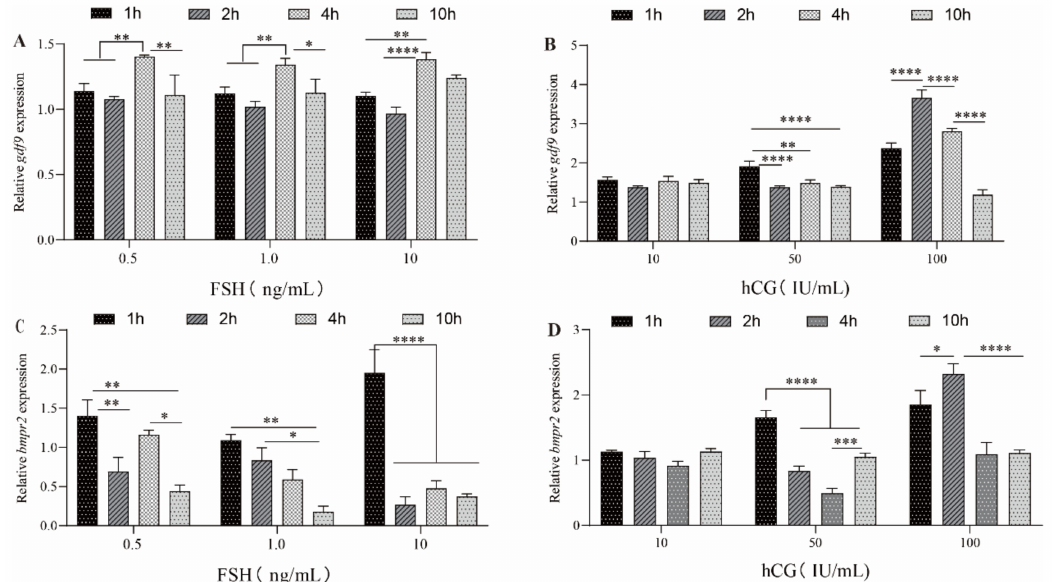
Figure 6. Expression of gdf9 and bmpr2 in ovarian tissue of ricefield eel after FSH and hCG incubation in vitro. Results are expressed as means ± SEM (error bars), which were compared with the control group. ( A , C ) The relative expression level of gdf9 and bmpr2 after FSH incubation; ( B , D ), the relative expression level of gdf9 and bmpr2 after hCG incubation. FSH, follicle-stimulating hormone; hCG, human chorionic gonadotropin; IU, international unit. *, **, *** and **** are the significant differences in Duncan’s multiple comparisons, representing * p < 0.05, ** p < 0.01, *** p < 0.001 and **** p < 0.0001,